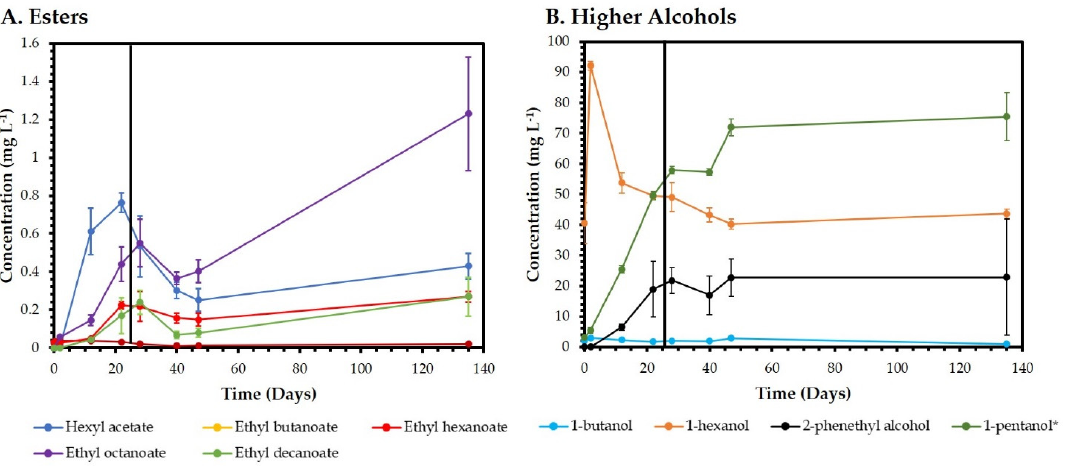
Figure 4. HS-SPME-GCMS measurements of headspace ester ( A ) and higher alcohol ( B ) concentra- tions that represent the overall trends observed from juice (day 0) to mature cider (day 135). Day 25 (vertical black line) is the date of cold crashing and racking the cider samples. Error bars and are reported as 𝑥 ± 1 s of triplicate samples.